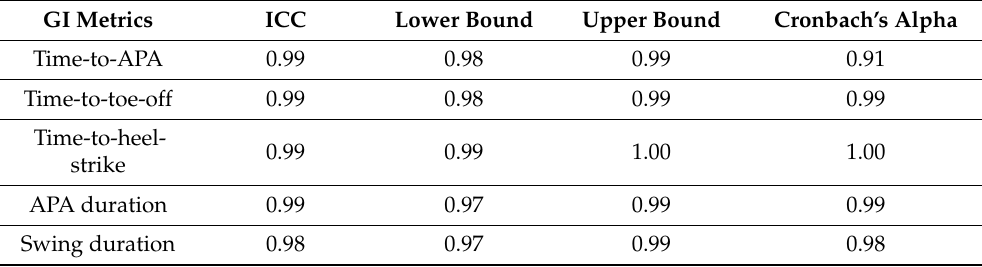
Table 3. Intraclass correlation coefficients (ICC) of gait initiation (GI) metrics extracted from the inertial measurement unit and the force